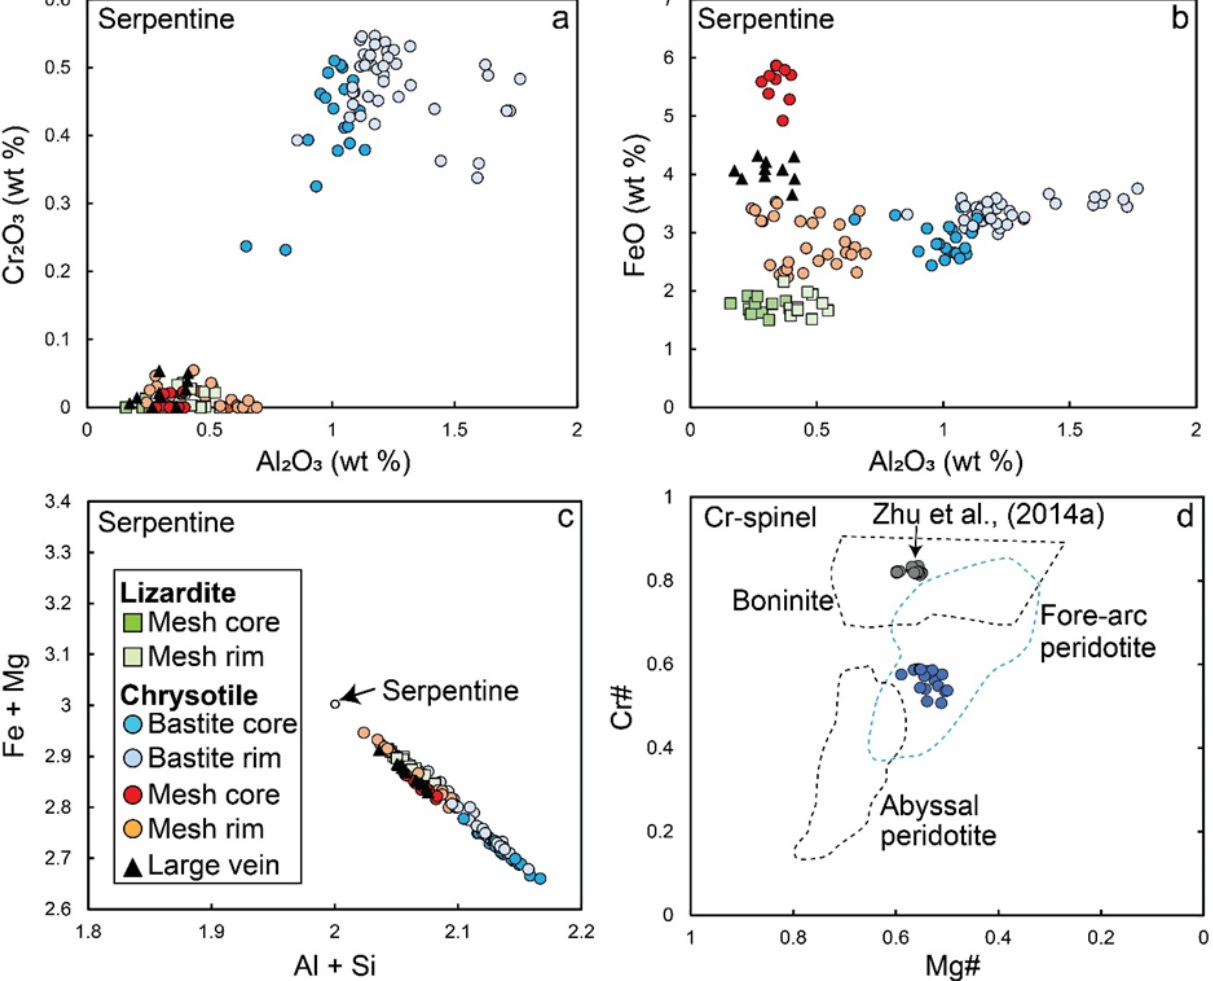
Fig. 4. Mineral chemistry. (a) Diagram comparing the Cr textured serpentines. (b) Diagram comparing the FeO vs Al serpentines. (c) Chemical compositions of serpentine minerals as a function of Si + Al and Mg + Fe cations per seven oxygens. Model serpentine (Mg = 3 and Si = 2) is shown as the open circle. (d) Plot of Mg# vs Cr# for the chromian spinels in serpentinite (blue) and in chromitite (green, from Zhu et al., 2014). Areas of abyssal peridotite, fore-arc peridotite, and boninite are from Tamura and Arai